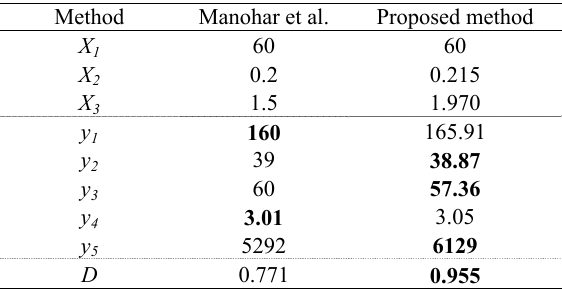
Table 19. Comparison of results for example 4: Methods from literature and approach proposed